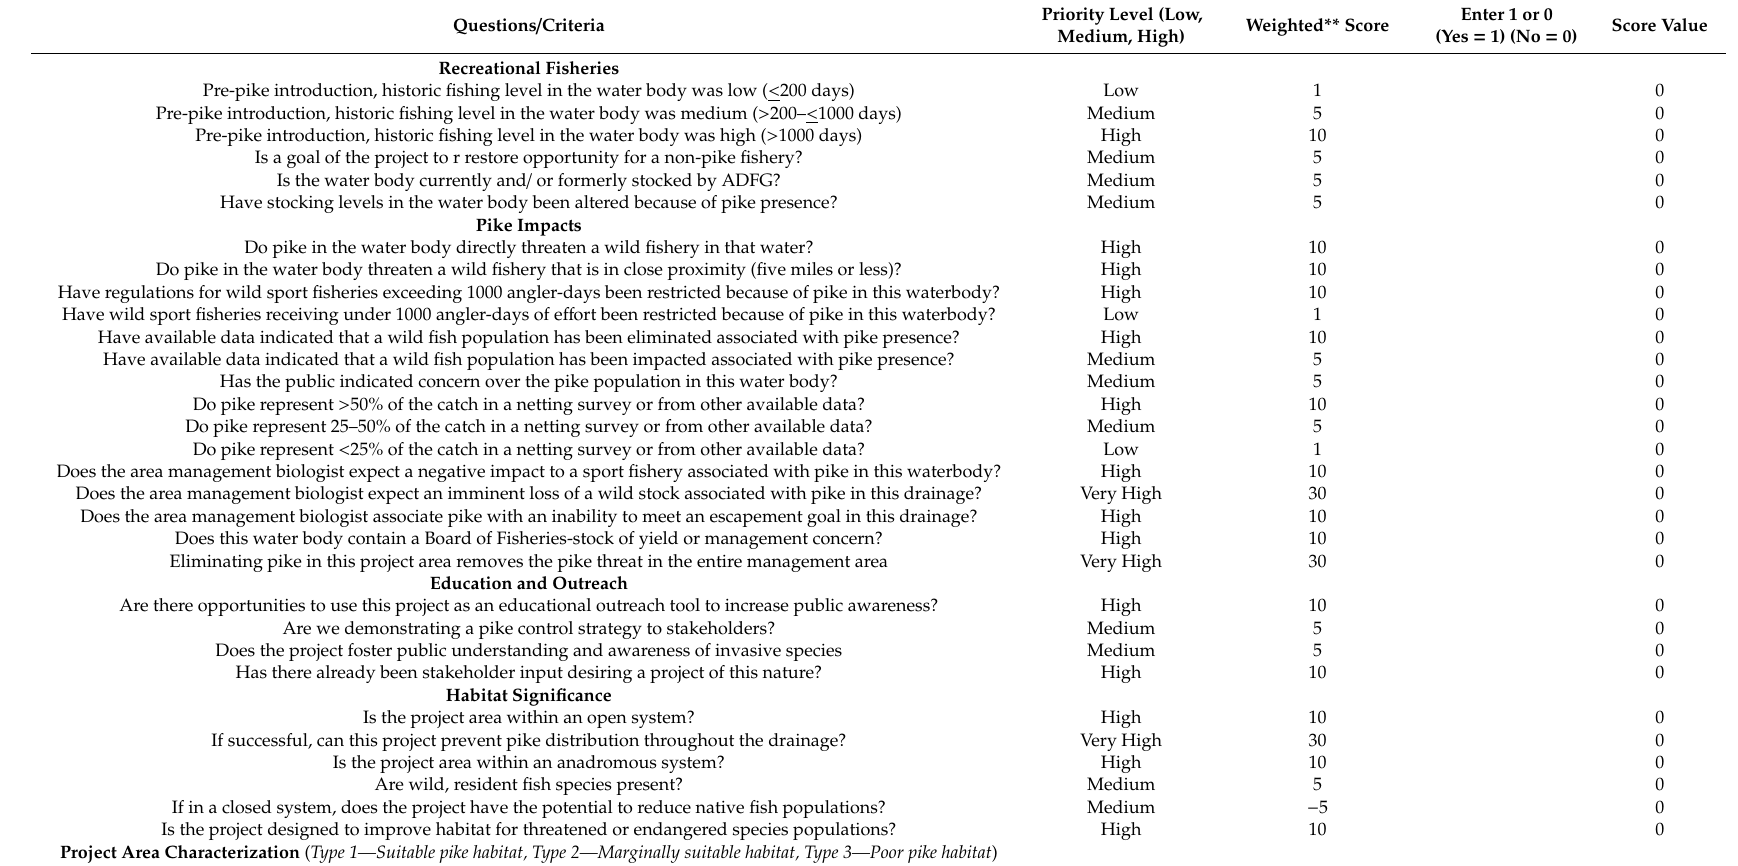
Table A1. ADFG Sport Fish Division Invasive Northern Pike Project Prioritization